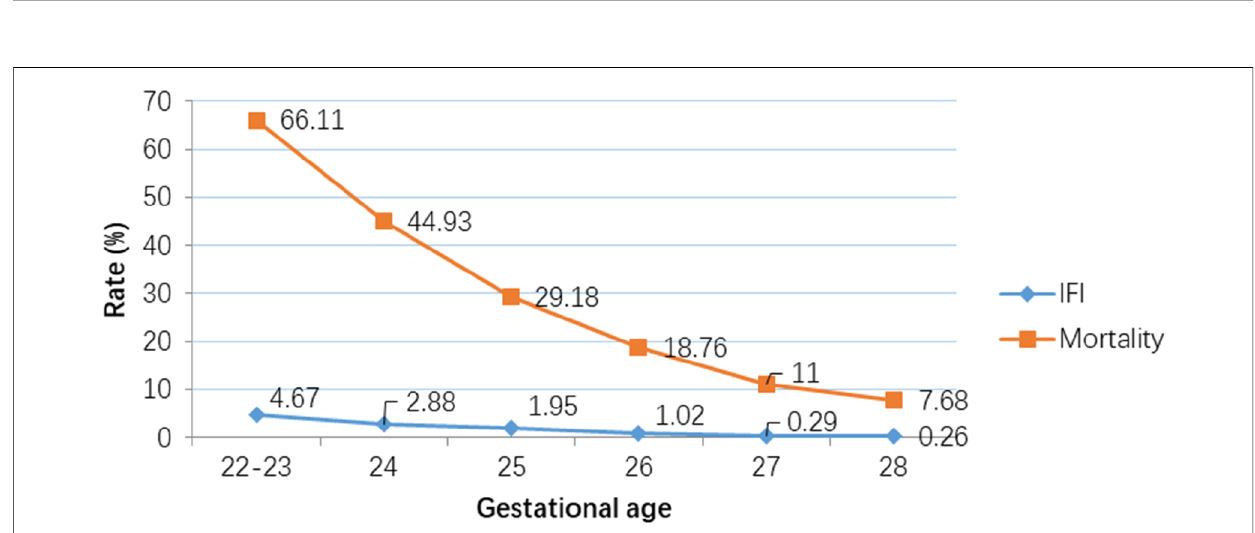
FIGURE 2 Rates of Invasive Fungal Infection (IFI) by year. No signi fi cant trend was observed (Armitage trend test: p =0.27).